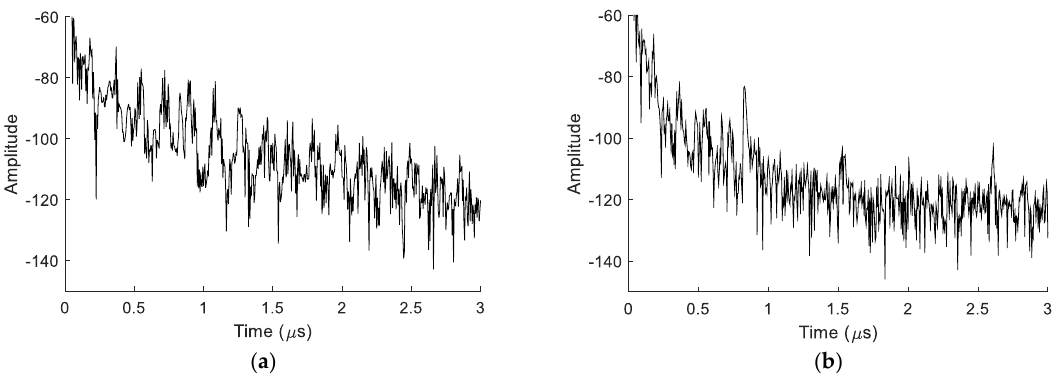
Figure 5. Improvement of the impulse response, using smaller pads and an absorbing layer (nail polish) on the back side, to reduce the amplitude of spurious BAW noise. ( a ) Before; ( b )